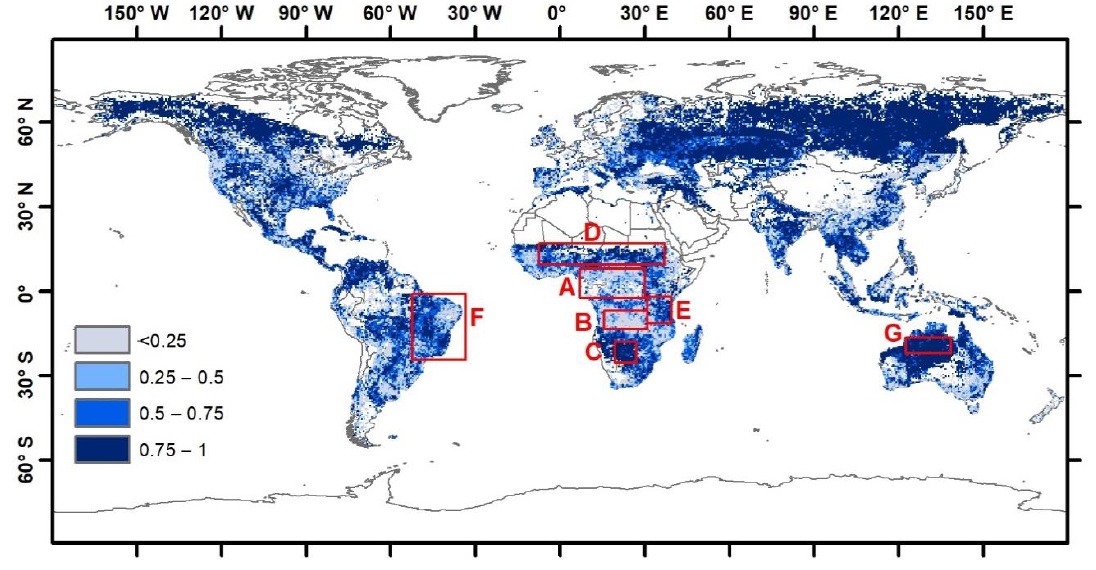
Figure 3. Global subset with seven regions of interest (A to G).